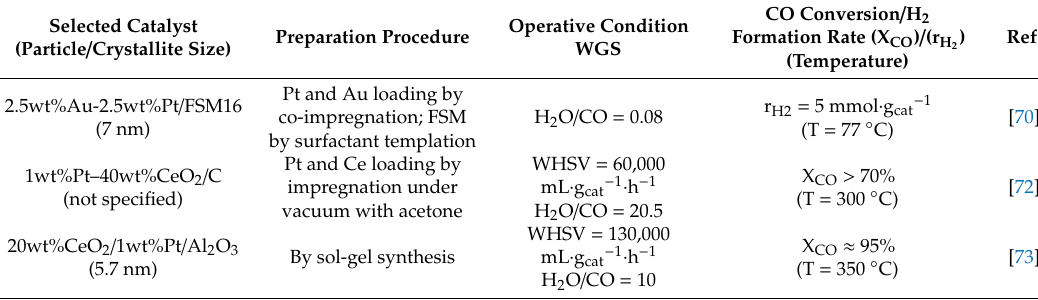
Table 4. Summary of the main catalytic results from the articles reported in Section 2.3.3 (the addition of promoters to the